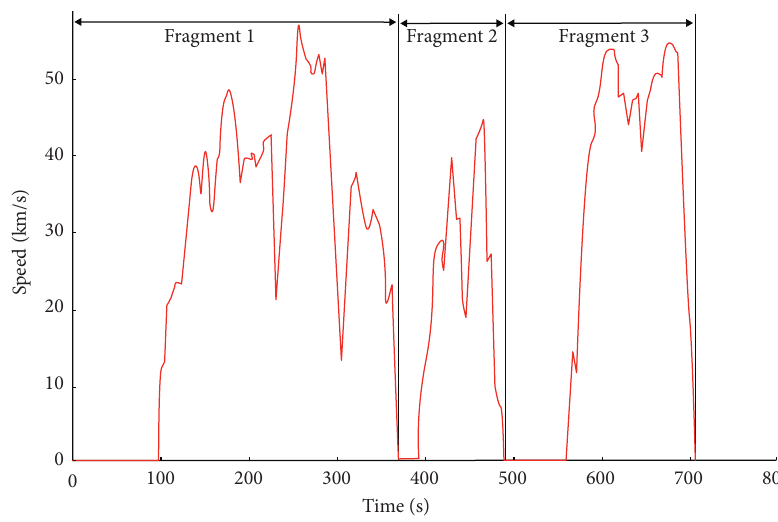
Figure 4: Segmentation of kinematic fragments.